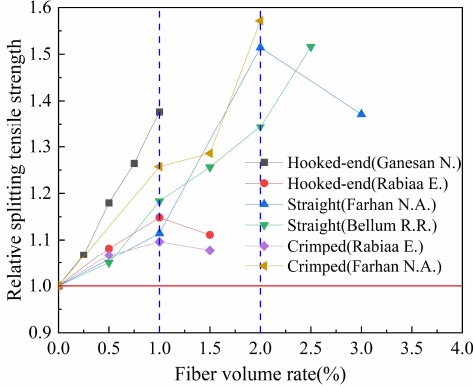
Figure 17. The effect of fiber shape on splitting tensile